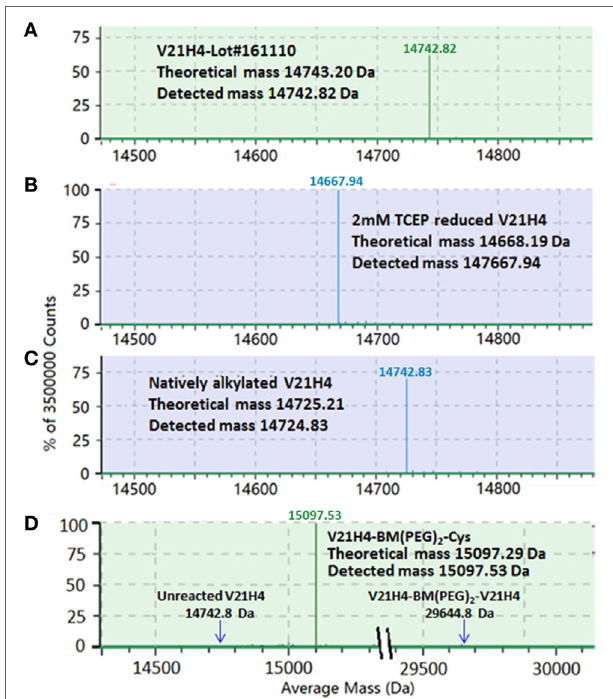
FigUre 4 | (a–D) Screen snapshots of intact protein mass spectra of V21H4 samples from BiopharmaLynx. (a) Deconvoluted spectrum of V21H4 showing the attachment of a half cystamine to the C-terminal cysteine by forming a disulfide bond during refolding. (B) The deconvoluted spectrum of V21H4 after reduction with 2 mM TCEP showing the detachment of the C-terminal half cystamine. (c) The deconvoluted spectrum of the reduced V21H4 after alkylation with iodoacteamide showing the C-terminal cysteine is accessible to a sulfhydryl activation cross-linker. (D) Deconvoluted mass spectrum of V21H4 after activation by cross-linker and linkage to cysteine. V21H4 antibody activated by BM(PEG) 2 generates a single activated